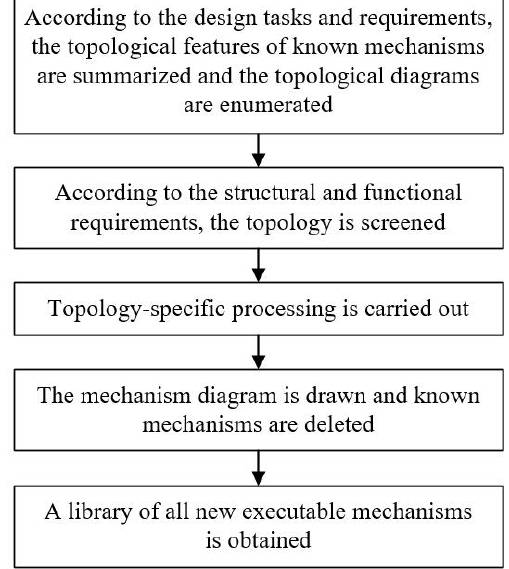
Figure 2. Flow chart of the innovative mechanism configuration